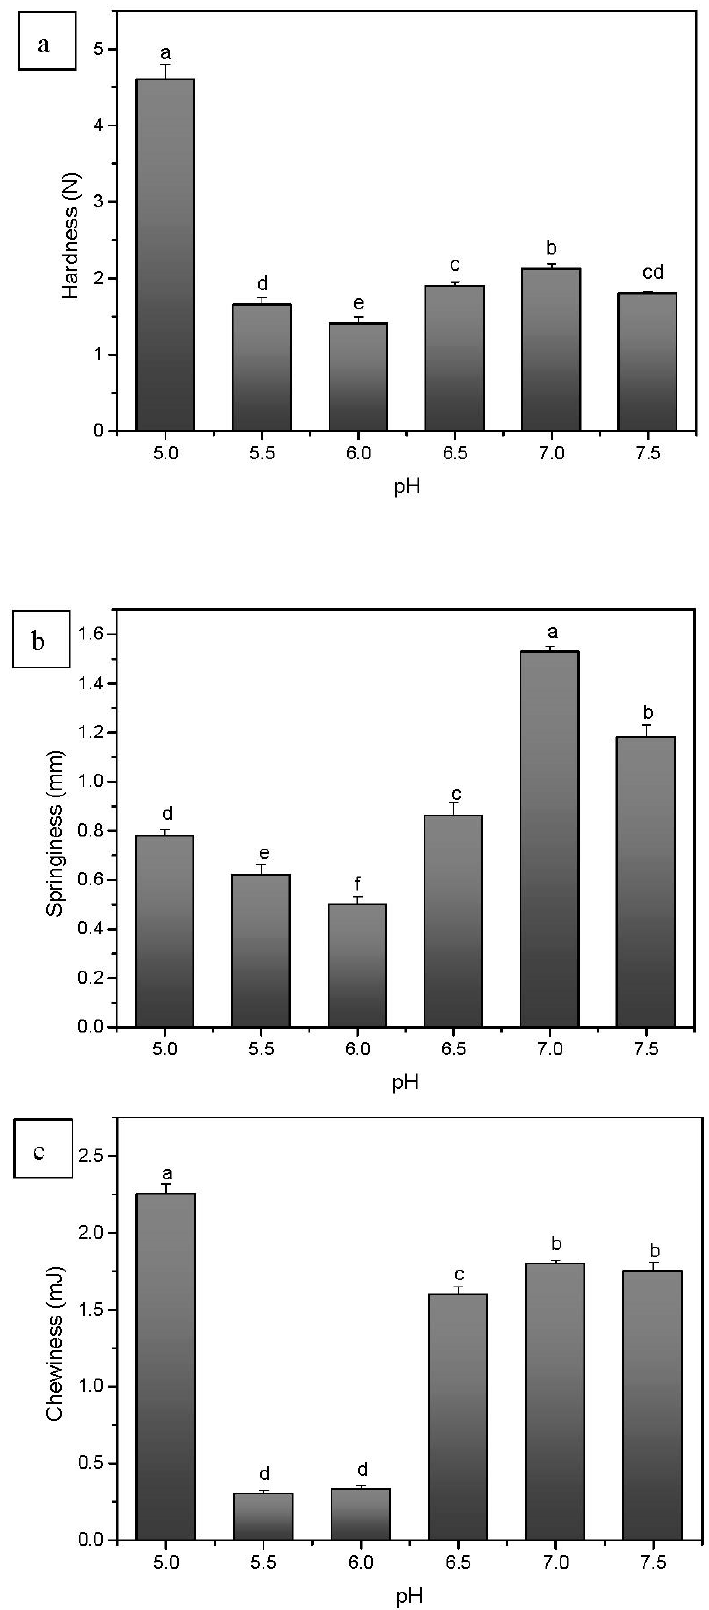
Figure 5. Textural properties of CFG-SPI DN hydrogels at pH 5.0–7.5. (( a ) Hardness; ( b ) Springi- ness; ( c ) Chewiness). Different letters (a–f) indicate statistically significant differences between different pH values ( p < 0.05).